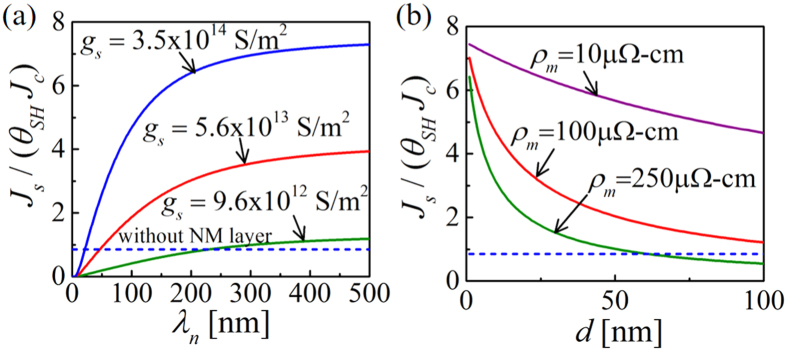
(a) Js/(θSHJc) as a function of NM spin diffusion length (λn) for different YIG|NM interface conductances: 9.6 × 1012 S/m2  (ref. 24), 5.6 × 1013 S/m2  (ref. 33), and 3.5 × 1014 S/m2 (estimated by comparing our model with experiment27, see Supplementary Information). Magnon resistivity and diffusion lengths are assumed 10 μΩ-cm and 10 μm respectively for this simulation. (b) Js/(θSHJc) as a function of YIG thickness for different magnon resistivity: 10 μΩ-cm (estimated by comparing our model with experiment27, see Supplementary Information), 100 μΩ-cm, and 250 μΩ-cm2427. The interface conductance and magnon diffusion length are assumed as 3.5 × 1014 S/m2 and 10 μm respectively for this simulation.